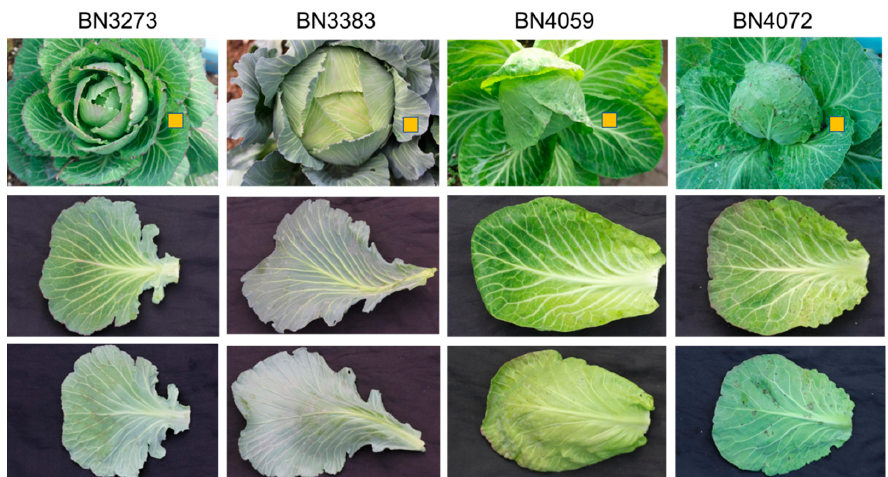
Figure 2. Genotypic variation in the leaf morphology of middle-aged leaves of four B. oleracea capitata inbred lines. Each column represents the whole plant, the upper- and lower-surface of an individual leaf, respectively. The leaves marked with orange-boxes were sampled. The inbred line BN3273 was the calibrator in the relative expression analysis.